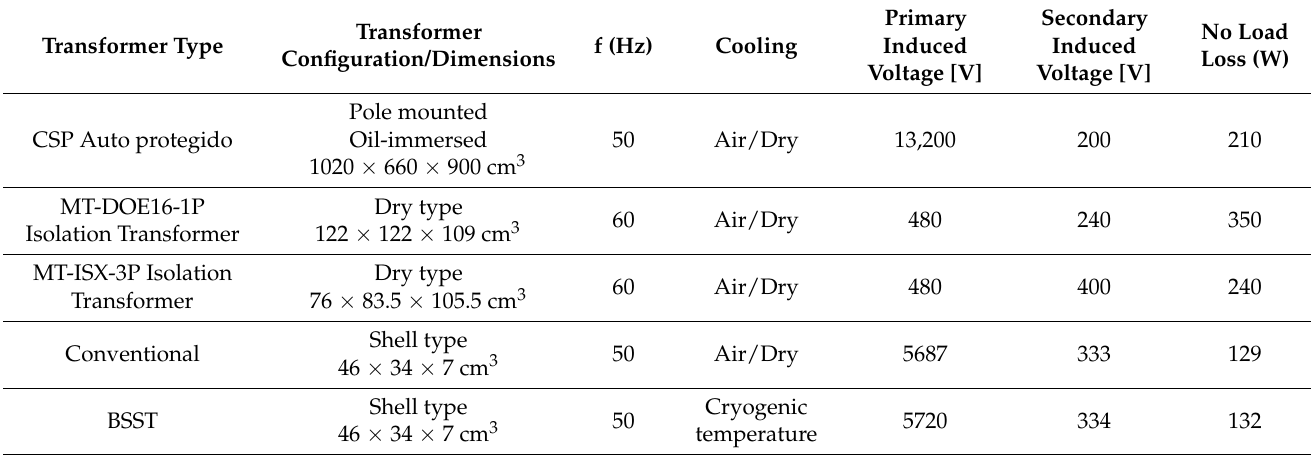
Table 4. 125 kVA rated power